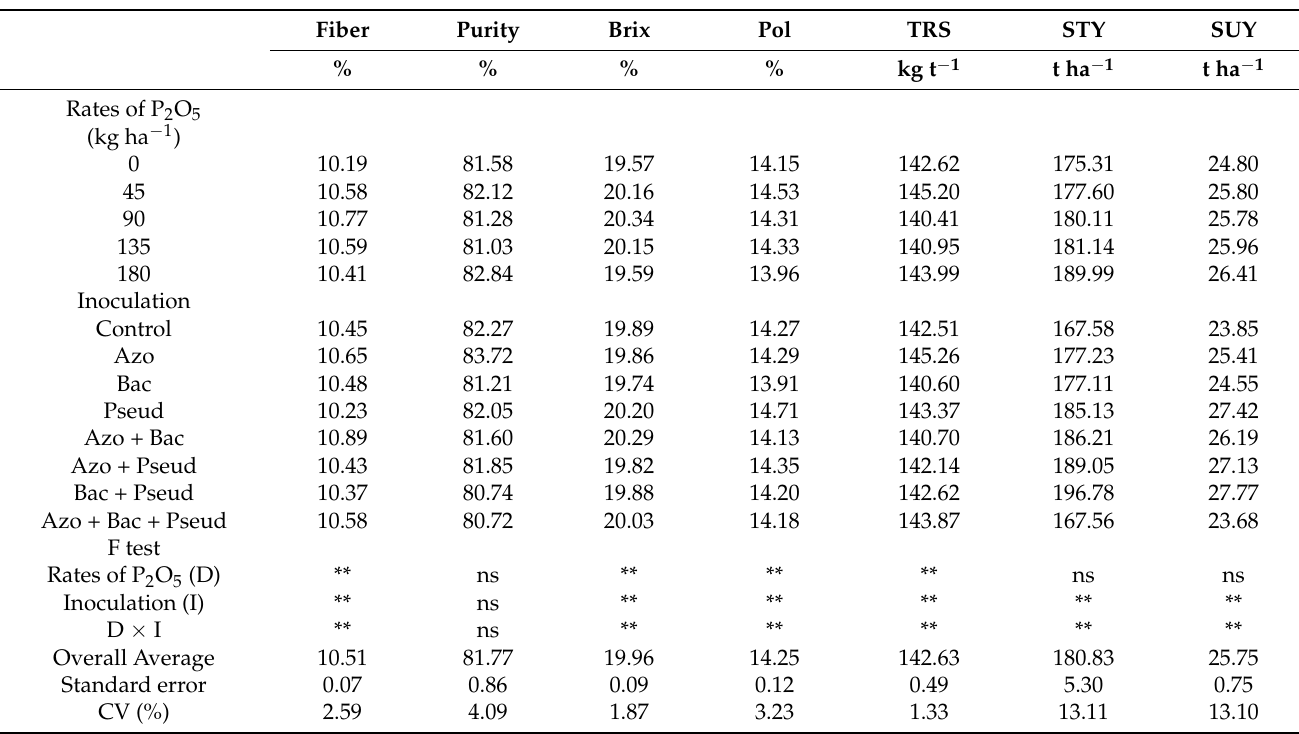
Table 3. Indicators of technological quality, stalk yield (STY) and sugar yield (SUY) of RB92579 sugarcane variety.